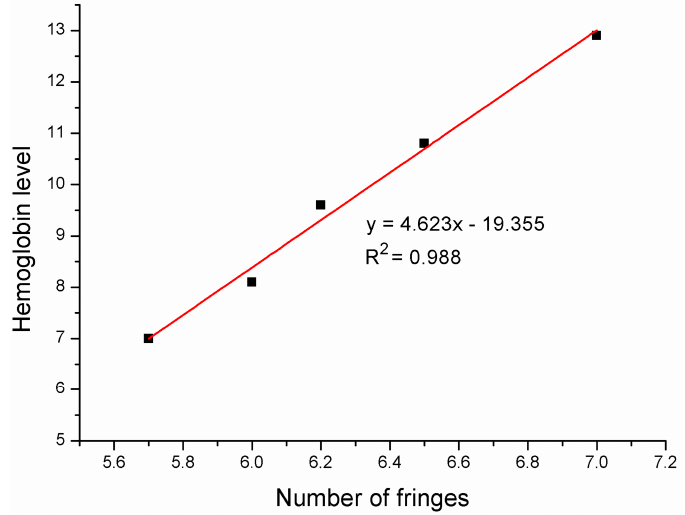
Figure 7. Hemoglobin level as a function of number of fringes—linear fit. Correlation coefficient R 2 = 0.988.